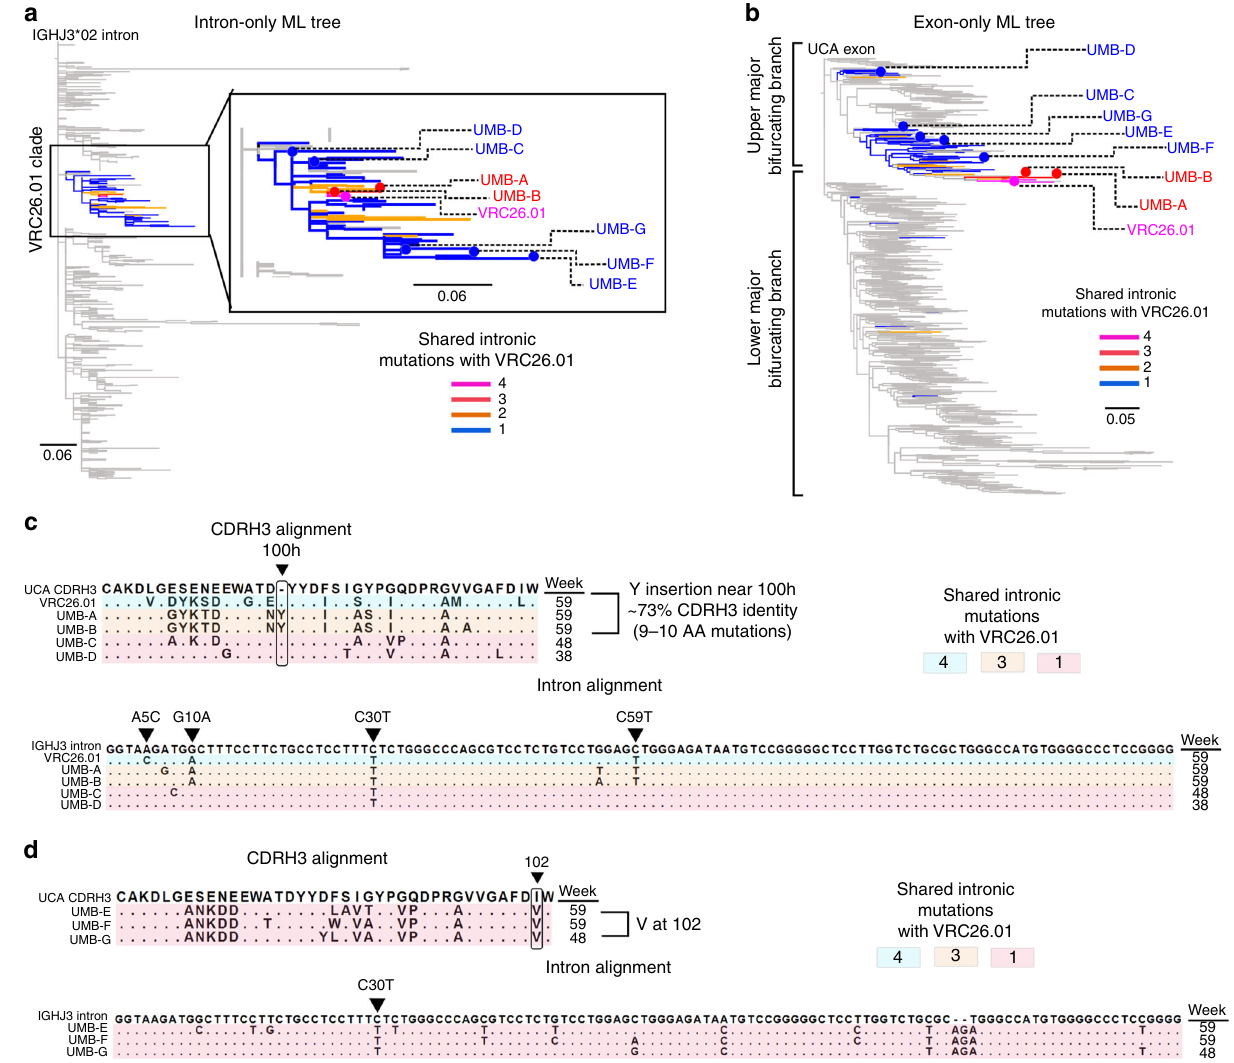
Fig. 6 VRC26.01 sublineage members have diverse CDRH3s but share intronic mutations. a Intron-only ML tree for all VRC26 lineage members. The Arg97 + disul fi de clade is highlighted by number of shared intronic mutations with ADS-4. Representative sequences are marked with UMB (Upper Major Bifurcating). b The exon-only ML tree for all VRC26 members is shown with the location of the highlighted sequences in a indicated. c CDRH3 and intron alignment for the representative sequences marked in a and b . Longitudinal time points of isolation are indicated. VRC26.01 intronic mutations are labeled and sequences are colored by the number of these mutations that they possess. UMB-A and UMB-B have a tyrosine position near position 100 h and have diverse CDRH3s from VRC26.01. d CDRH3 and intron alignment of sequences that diverge from VRC26.01 but share one intronic mutation. Longitudinal time points are shown and the CDRH3 site that contains convergent mutations is